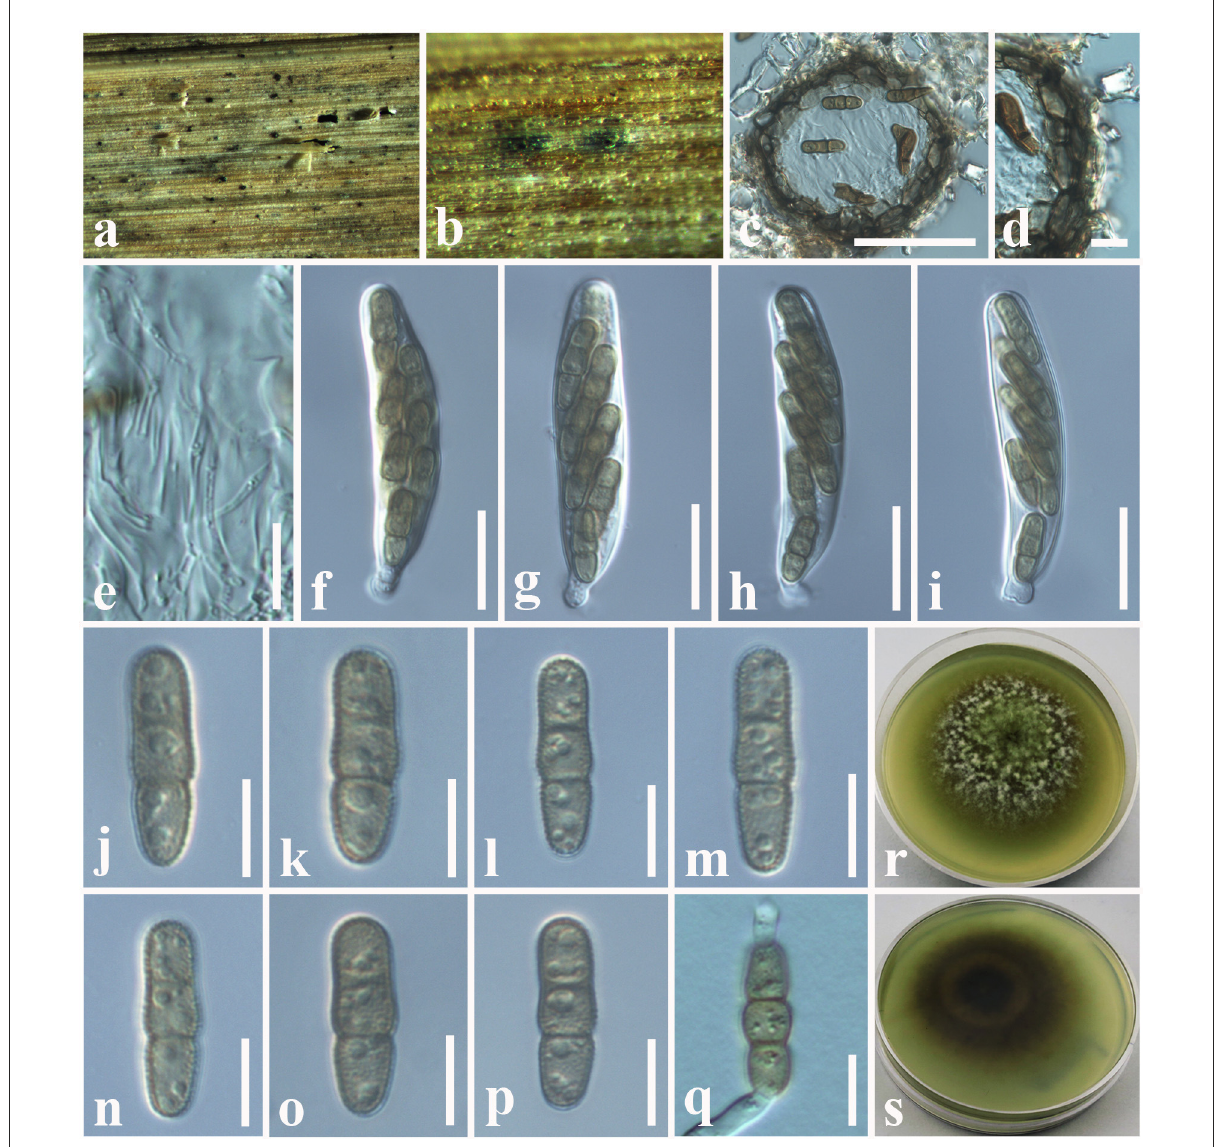
FIGURE9 Paraphaeosphaeria brachiariae (NCYU 19-0058, holotype). (a,b) Ascomata on a dead leaf of Brachiaria mutica . (c) Vertical section through an ascoma. (d) Peridium. (e) Pseudoparaphyses. (f–i) Asci. (j–p) Ascospores. (q) Germinating ascospore. (r) Upper side of the culture. (s) Lower side of the culture. Scale bars: (c) = 50 µ m, (d) = 10 µ m, (e–i) = 20 µ m, (j–q) = 7 µ m.